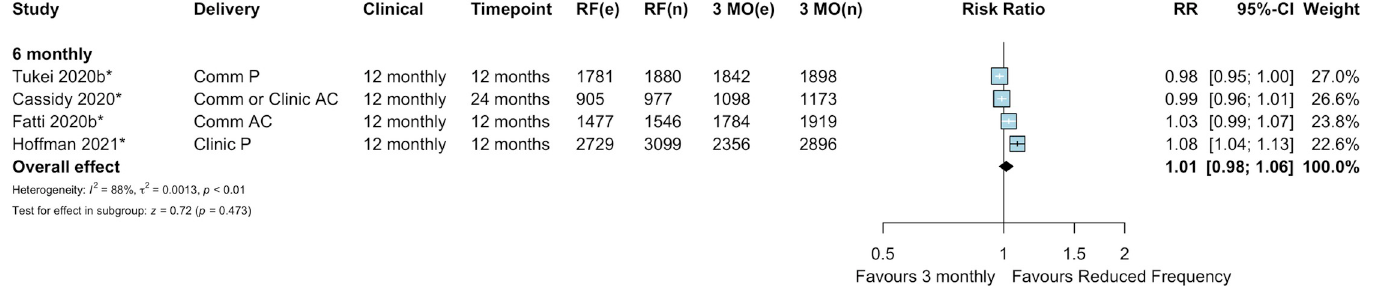
Fig 8. Retention in care: Reduced frequency versus 3-monthly antiviral treatment refills. � Cluster-adjusted RR. 3 MO, 3-monthly; AC, adherence club; Comm, community; e, number of events; n, number of participants; RF, reduced frequency; RR, risk ratio.